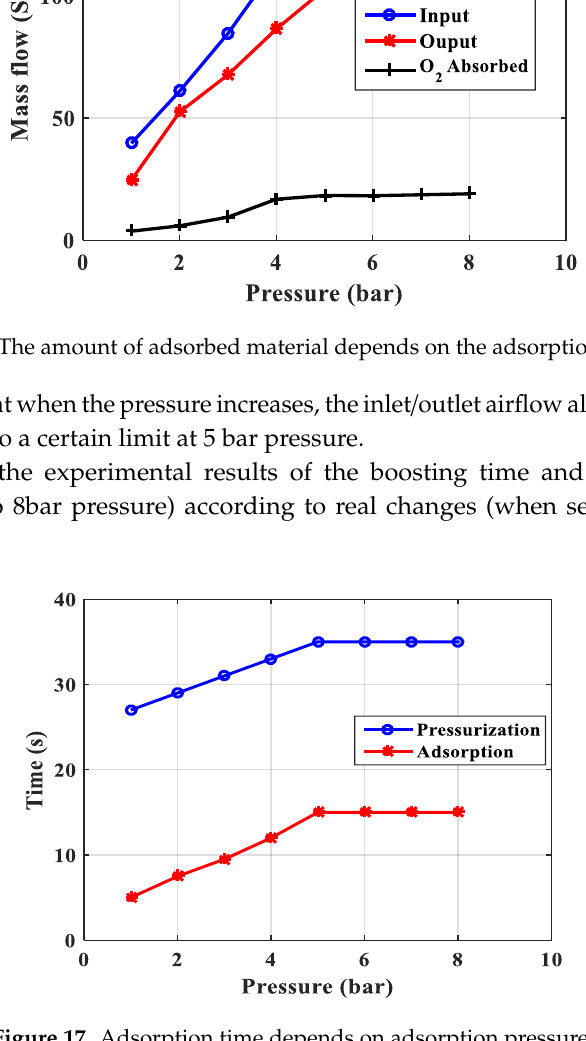
Figure 19. The dependence of N 2 concentration on adsorption pressure.